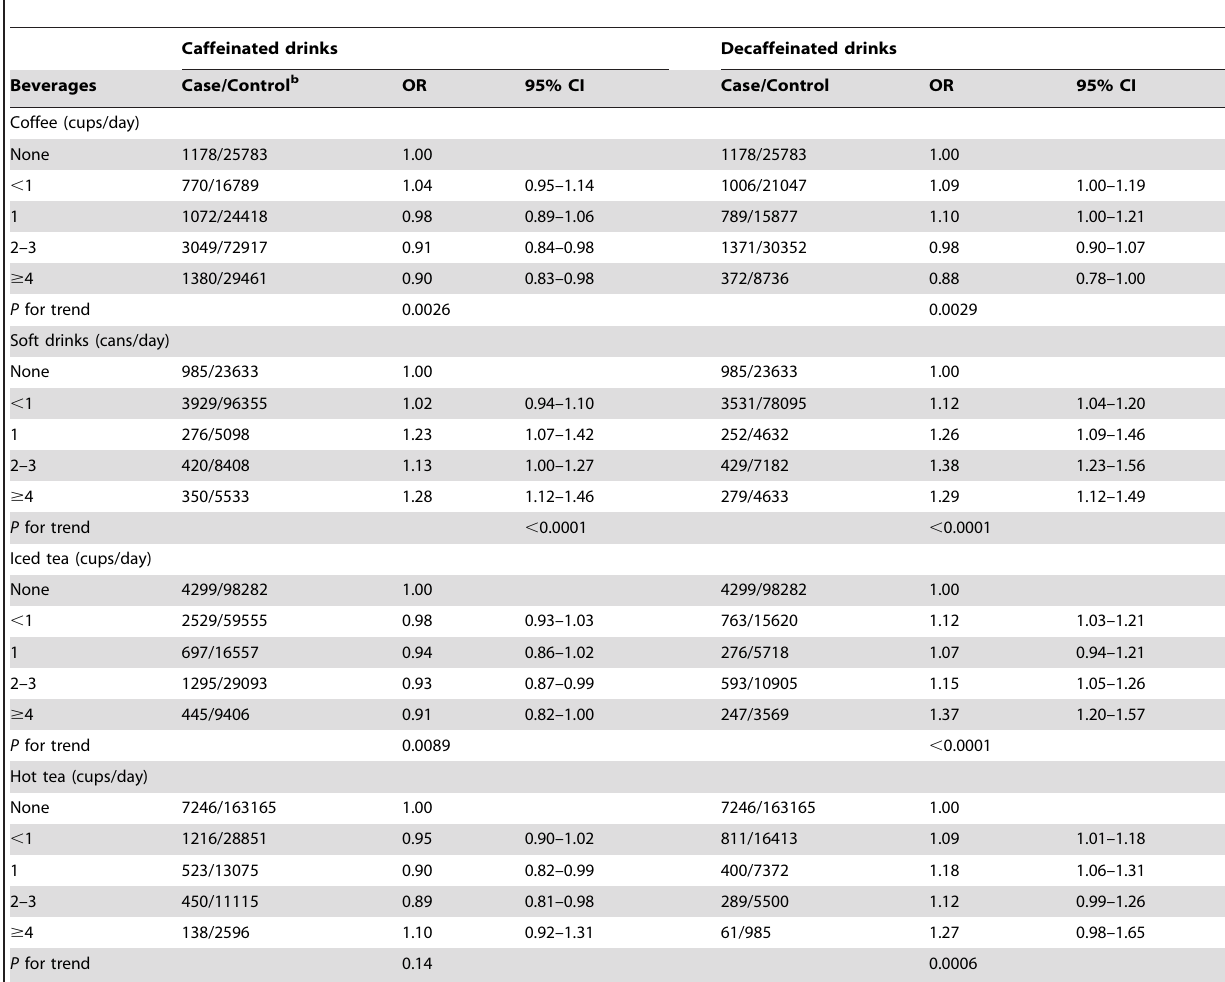
Table 4. Odds ratios a and 95% confidence intervals of depression according to baseline consumption of caffeinated or decaffeinated beverages in the NIH-AARP Diet and Health Study,